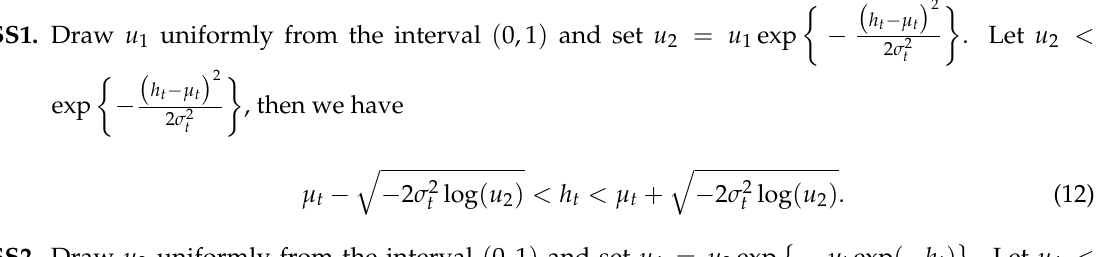
Algorithm of the slice sampler for h